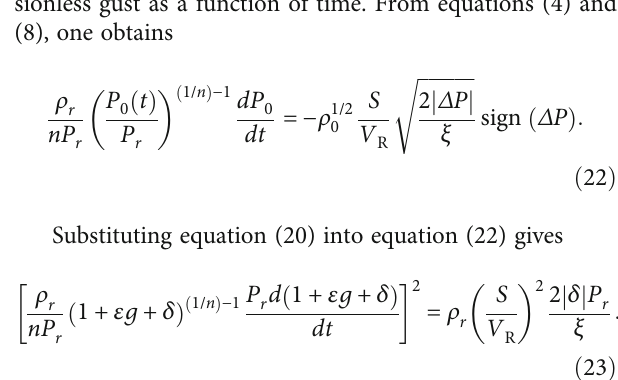
= 40Hz (i.e., U E = 5 to 6m/s), nominal gust frequency, f N mv m